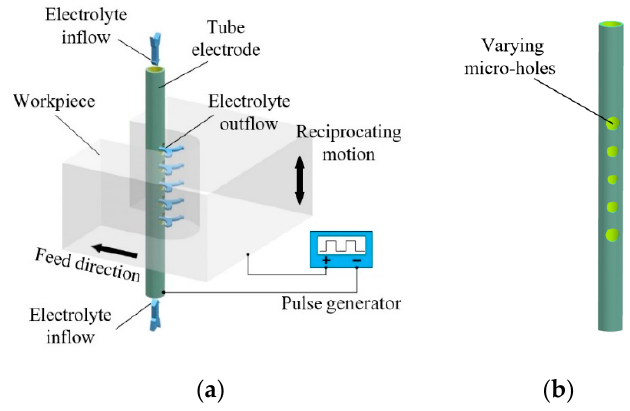
Figure 1. Schematic of wire electrochemical machining (WECM) with pulsating radial electrolyte supply: ( a ) Process; ( b ) the tube electrode with varying micro-holes on surface.